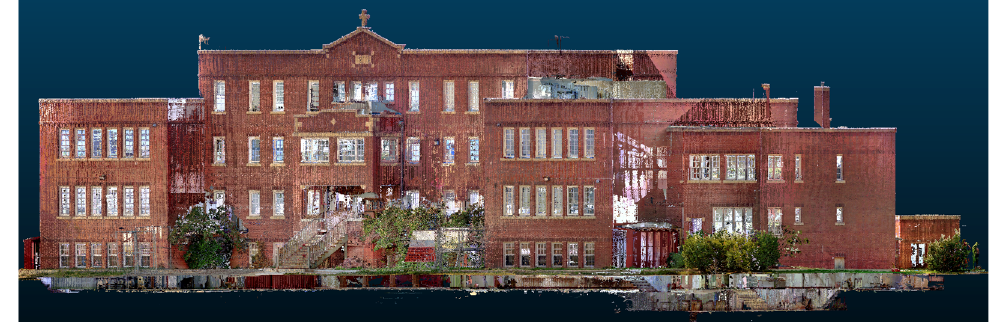
Figure 10. Old Sun Residential School: captured point cloud.